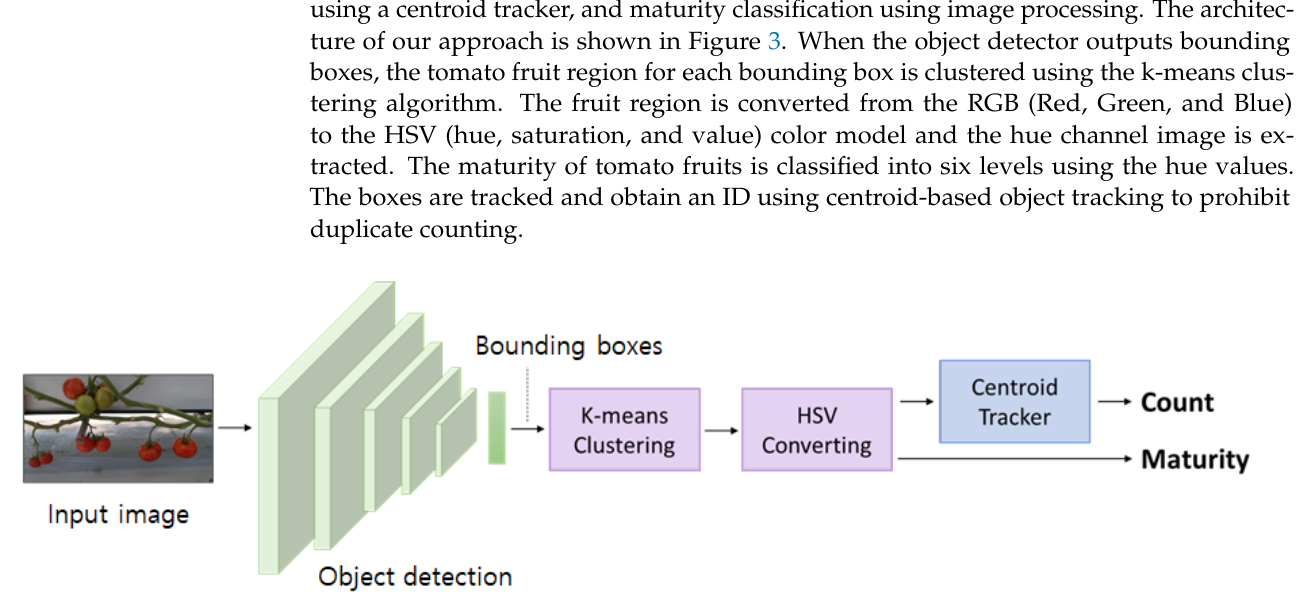
Figure 3. The architecture of the proposed system.